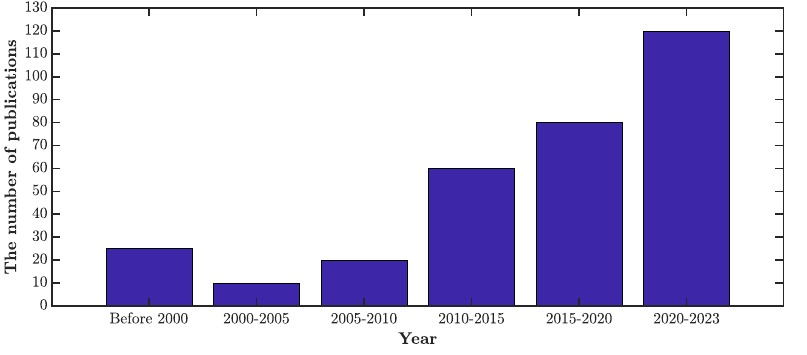
Figure 2. Number of reviewed articles by year. Table 6. Overview of reviewed journals and the covered content, i.e., optimization algorithms (OA), SHM systems, and OSP